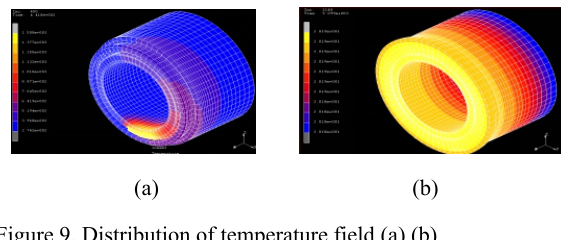
Figure 9. Distribution of temperature field (a)